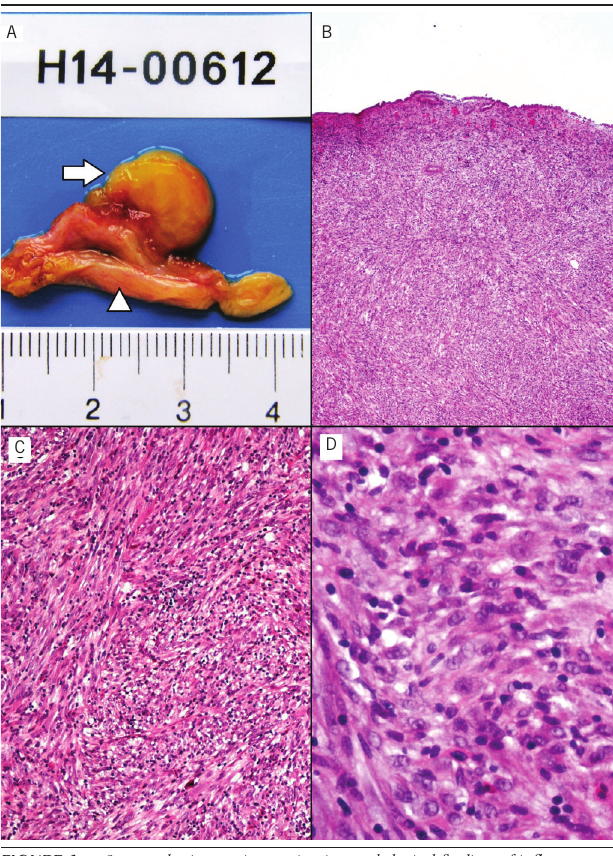
figuRE 1 − Gross and microscopic examination: pathological findings of inflammatory myofibroblastic tumour A) polypoid lesion (arrow) arising from the gallbladder wall (arrowhead), with 1.2 cm and yellowish cut section (macroscopic photograph); B) the lesion is located below gallbladder epithelium (HE stain, 40×); C) neoplastic spindle cell proliferation in a slightly oedematous background, rich in lymphocytes and plasma cells (HE stain, 100×); D) the neoplastic cells had eosinophilic cytoplasm and oval nuclei with small nucleoli (HE stain, 400×). HE: hematoxylin and